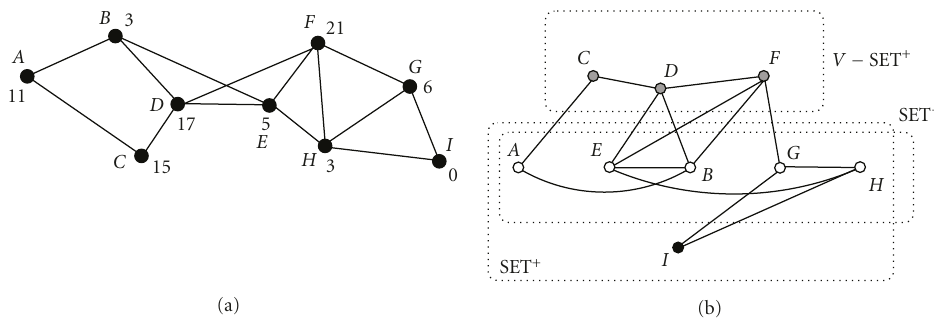
Figure 6: Constructing SET + and SET − in graph G . (a) Nodes are associated with their ζ values. (b) SET + and SET − in (a).